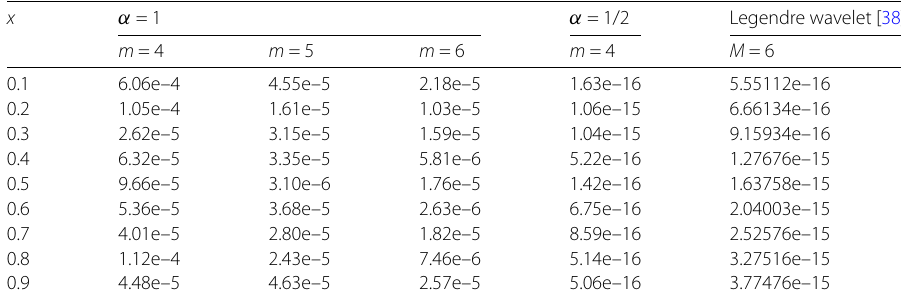
Table 1 The absolute errors for different α , m of the FEFs and M = 6 of the Legendre wavelet x α = 1 α = 1/2 Legendre wavelet [38] m = 4 m = 5 m = 6 m = 4 M = 6 0.1